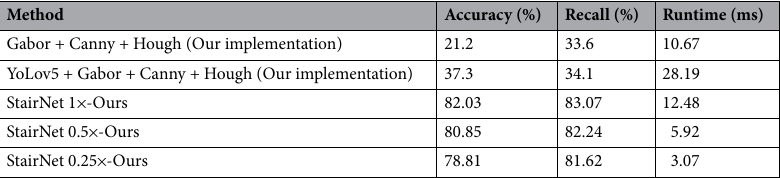
Table 5. Results of the comparison experiments.